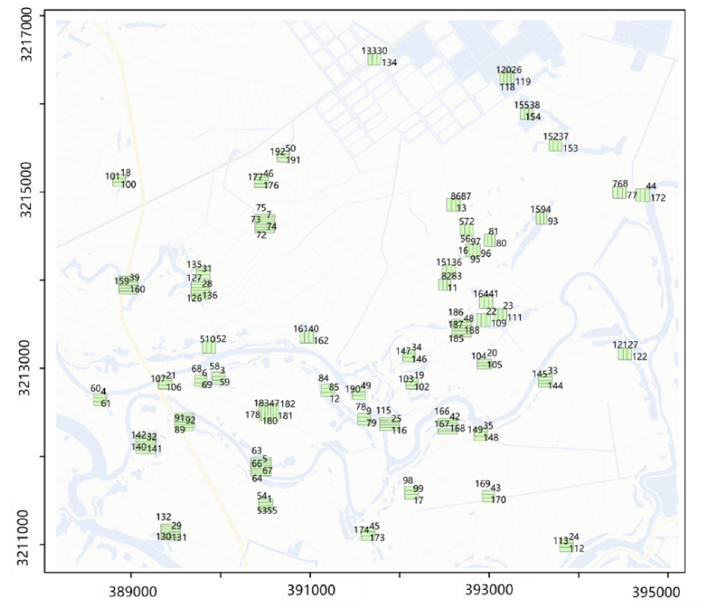
Figure 5. Results of the task decomposition.